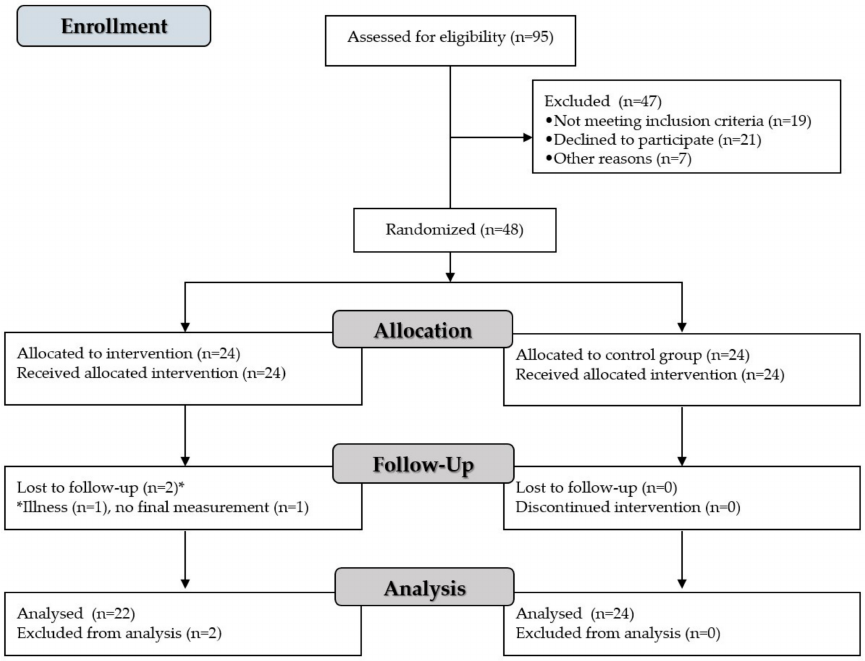
Figure 1. Flow diagram of the